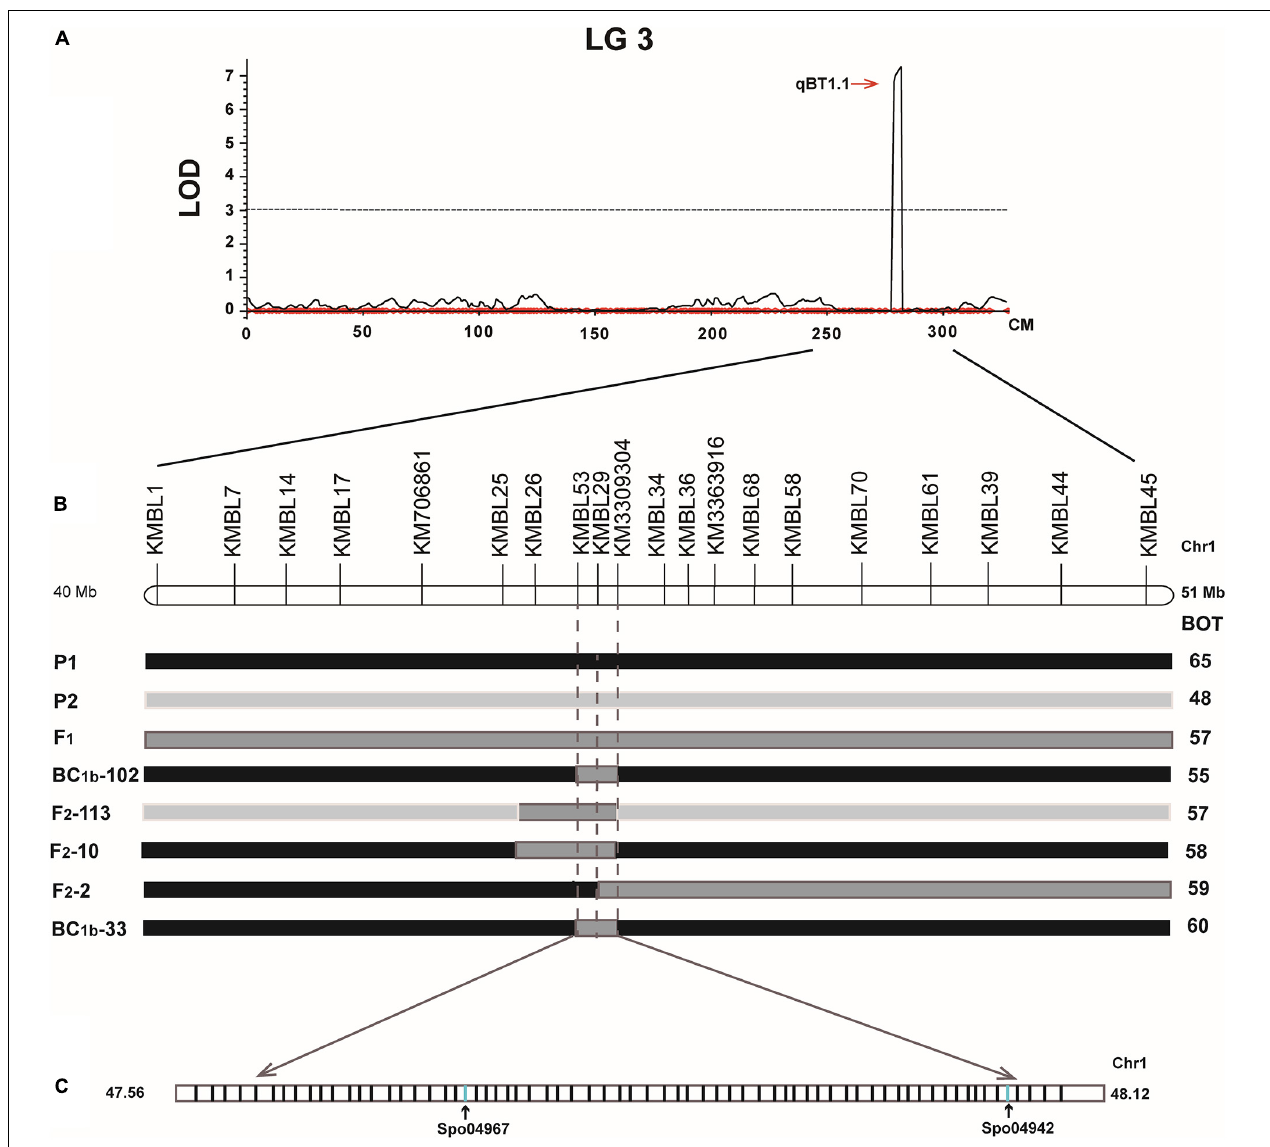
FIGURE 5 | Fine mapping QTLs controlling spinach bolting trait. (A) One QTL was mapped in LG3 using the BC 1a population; (B) fine mapping of the QTL controlling spinach bolting trait using the BC 1b and F 2 populations; (C) two candidate gene were identified in the interval from 47.56 Mb and 48.12 Mb of spinach chromosome